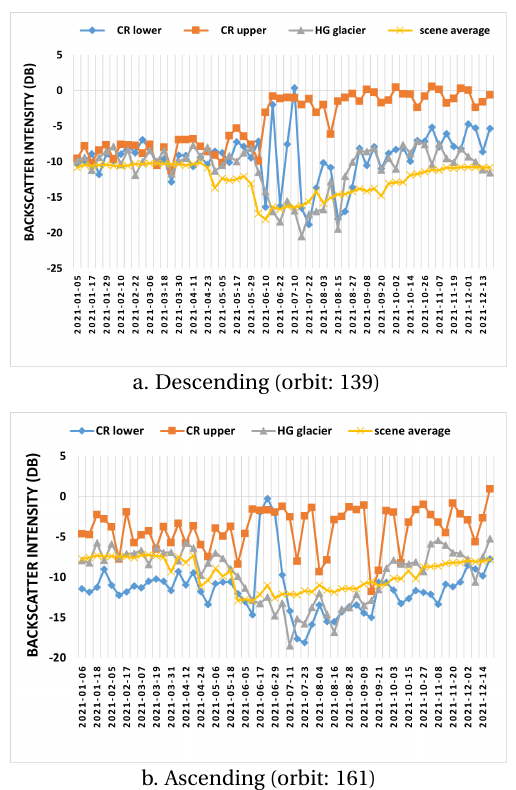
Figure 8. Backscatter coeffcient time series for Sentinel-1